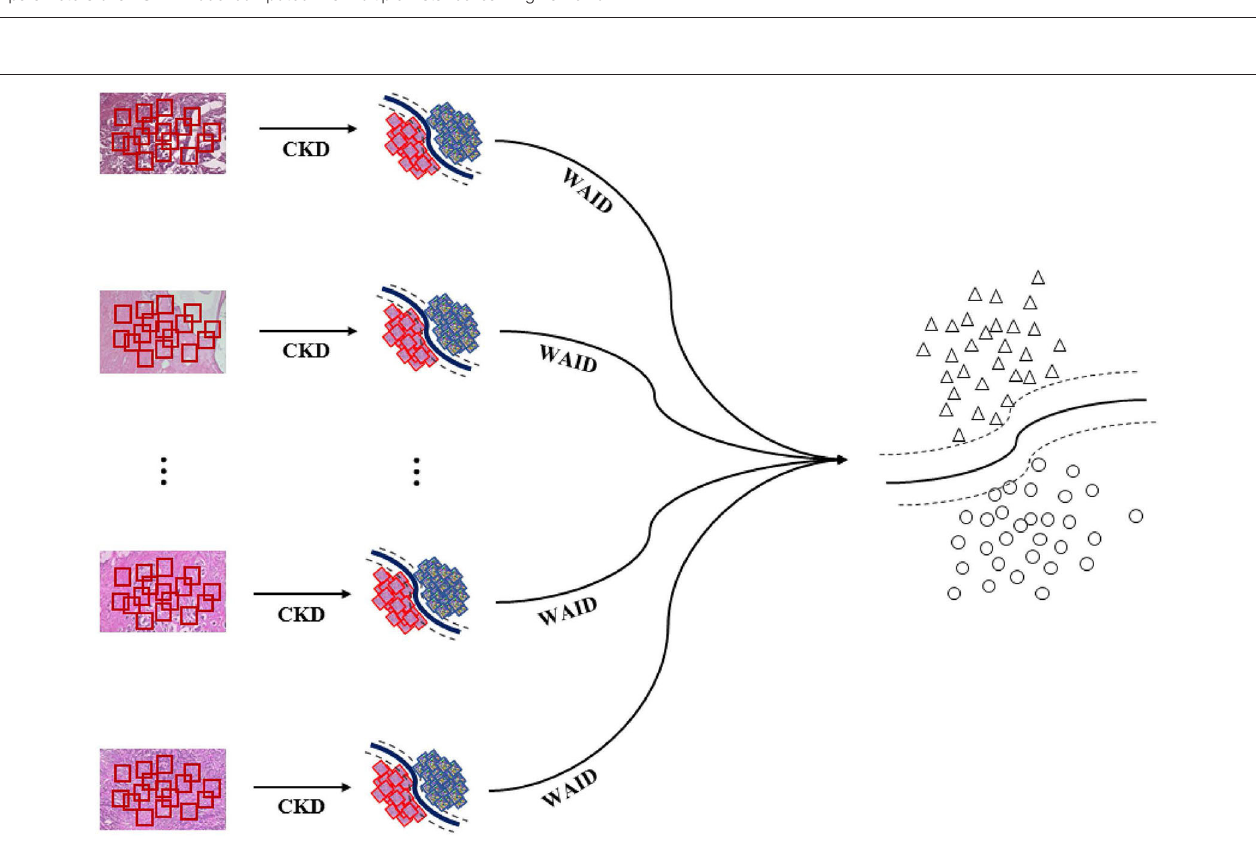
FIGURE 4 | Weakly annotated data processing. First, images are sub-sampled and CDKs are computed on every patch. Second, the WAID is computed for every group of patches. Finally, an SVM model is computed for classifying malignant images.